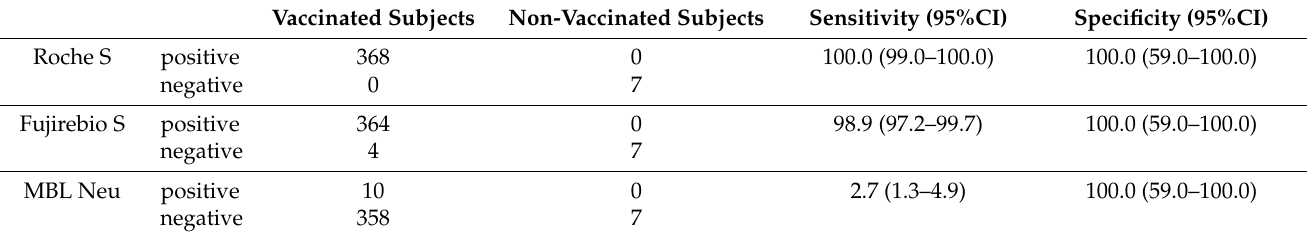
Table 2. Clinical performance of SARS-CoV-2 Ab assays.